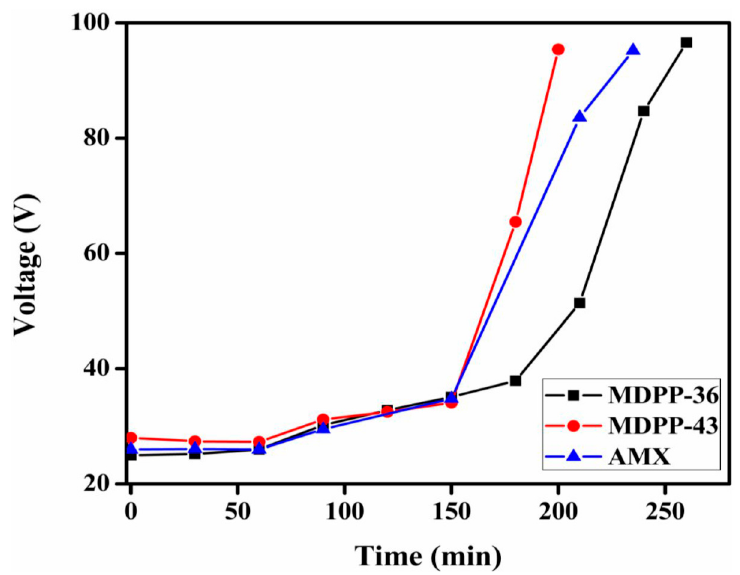
Figure 7. The change of potential over the stack with time. Table 4. The membrane ED performance compared to commercial membrane Neosepta AMX. Membranes